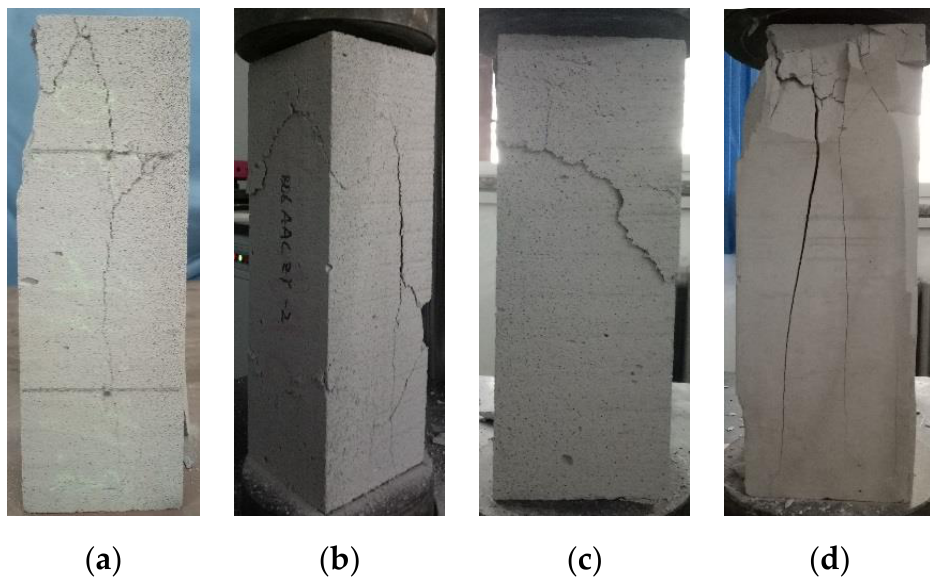
Figure 16. Failure mode of AAC and base material prism under axial compressive load: ( a ) AAC mode 1; ( b ) AAC mode 2; ( c ) AAC mode 3; ( d ) base material mode.